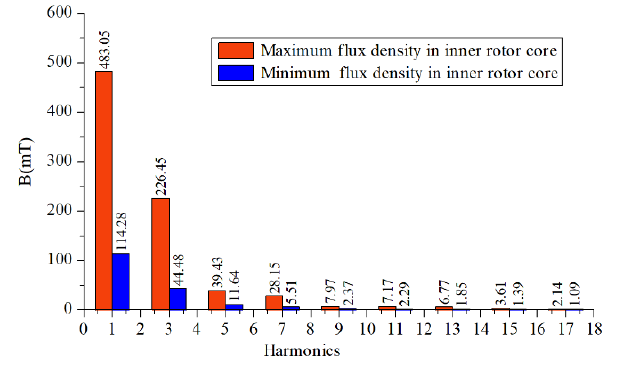
Figure 12. The maximum and minimum FFT values of the harmonics in the inner rotor core.